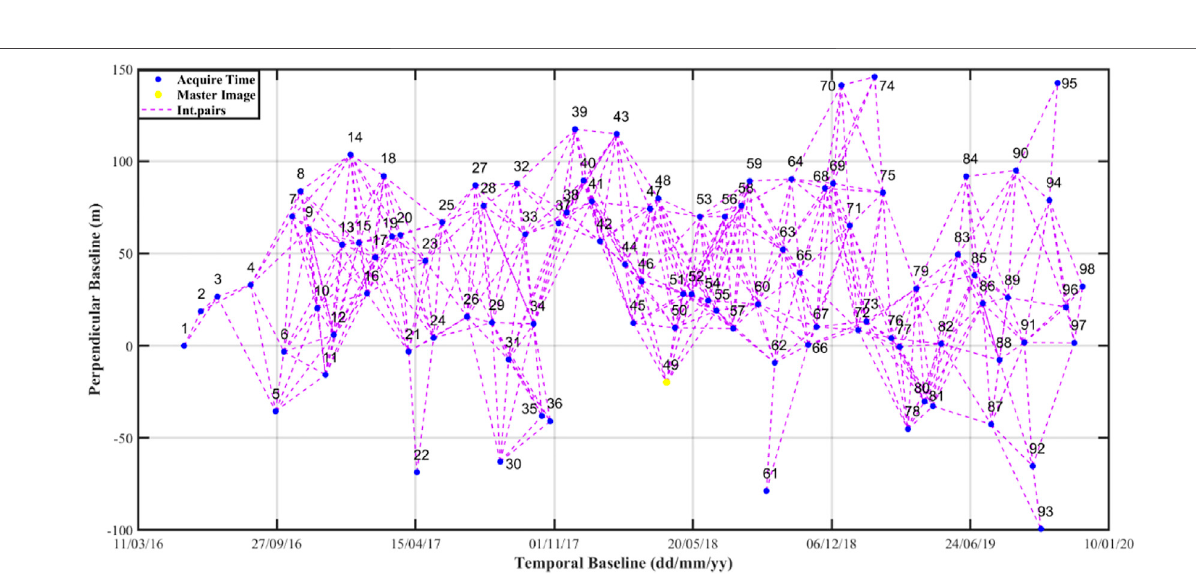
Frontiers in Environmental Science |